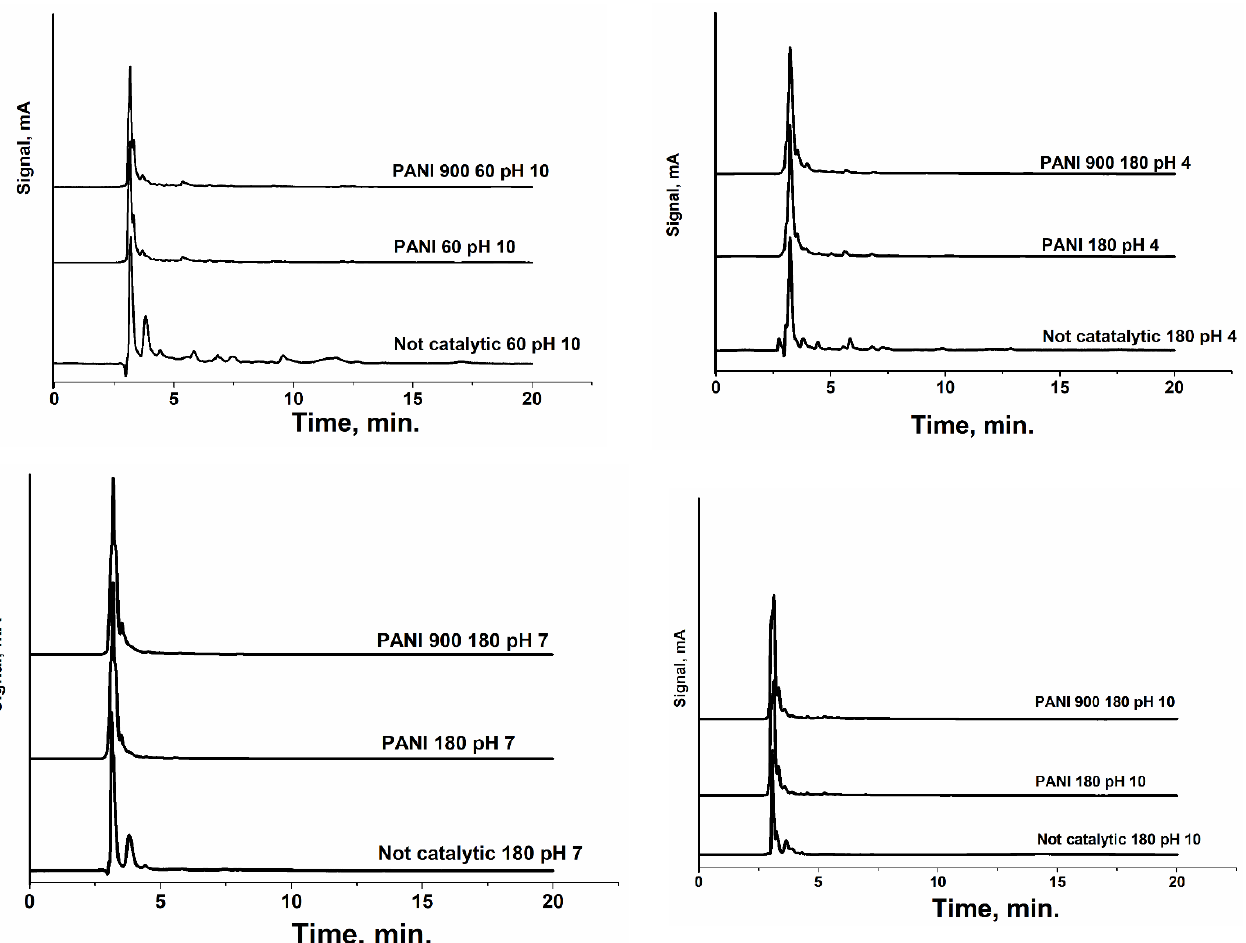
Figure 14. Chromatograms of samples extracted from reaction media at three pH values and different time intervals.